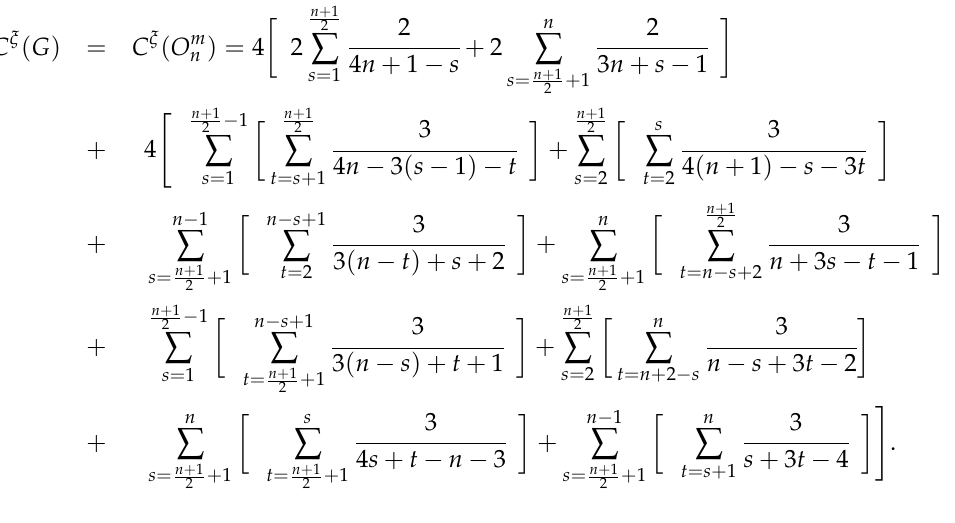
Table 2. Partition of vertices of the type u t s of O m n based on degree and eccentricity of each vertex when n ≡ 1 ( mod 2 )